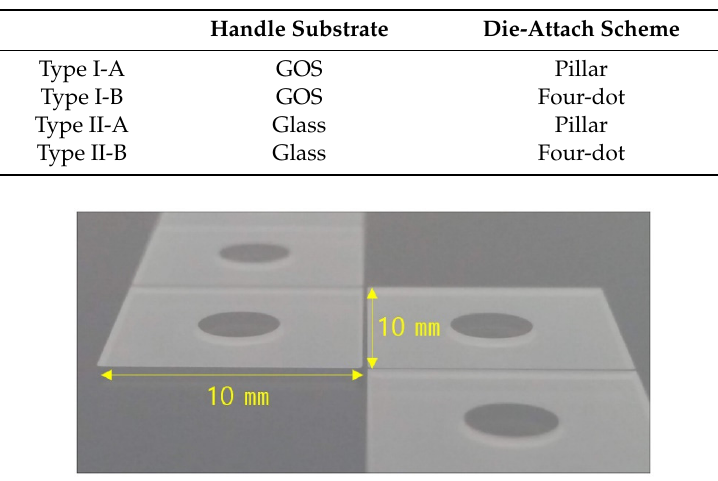
Figure 3. Cross-sectional Views of the Four Types of DRAs (not to scale): ( a ) Type I-A; ( b ) Type I-B; Figure 3. Cross ‐ sectional Views of the Four Types of DRAs (not to scale): ( a ) Type Ⅰ ‐ A; ( b ) Type Ⅰ-B; ( c ) Type II-A; and ( d ) Type II-B. ( c ) Type Ⅱ-A; and ( d ) Type Ⅱ-B. Table 1. Definitions of DRA types. GOS: glass-on-silicon. Table 1. Definitions of DRA types. GOS: glass ‐ on ‐ silicon.